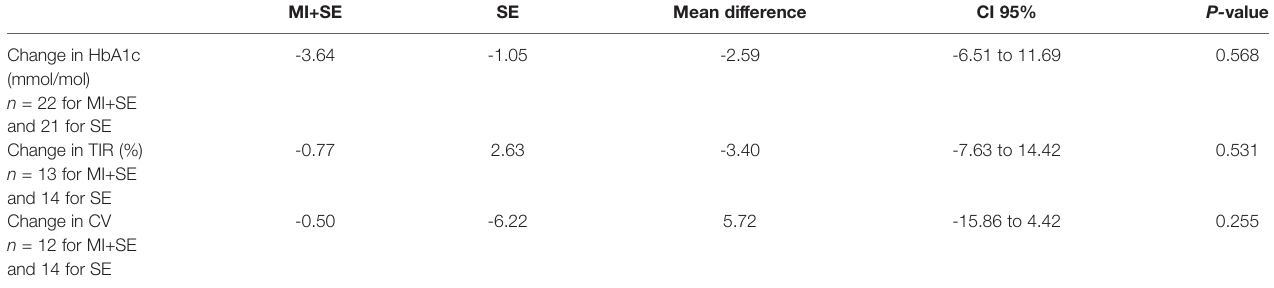
TABLE 3 | Mean baseline-adjusted 12-month changes in HbA1c, time in range, and coef fi cient of variation for the MI+SE and the SE group. MI+SE SE